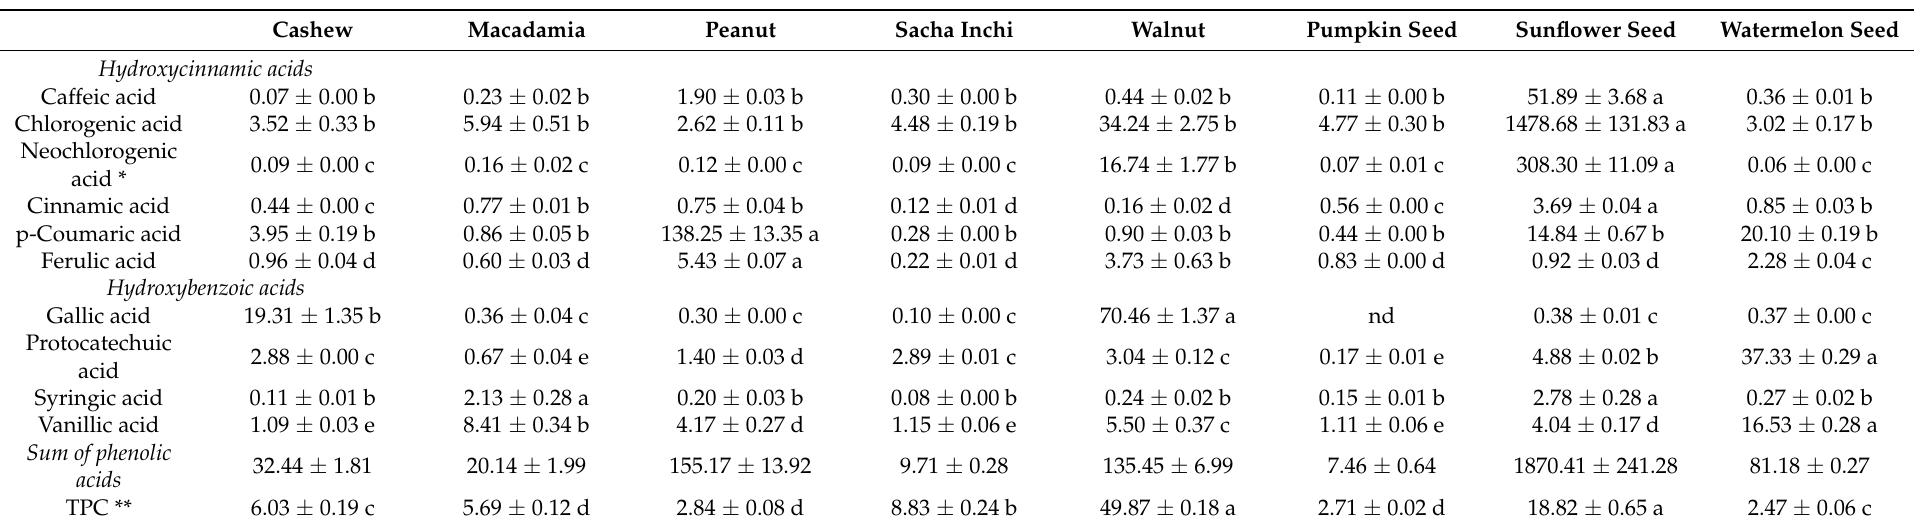
Table 4. Phenolic acids ( µ g/g FW) of the studied nuts and seeds.